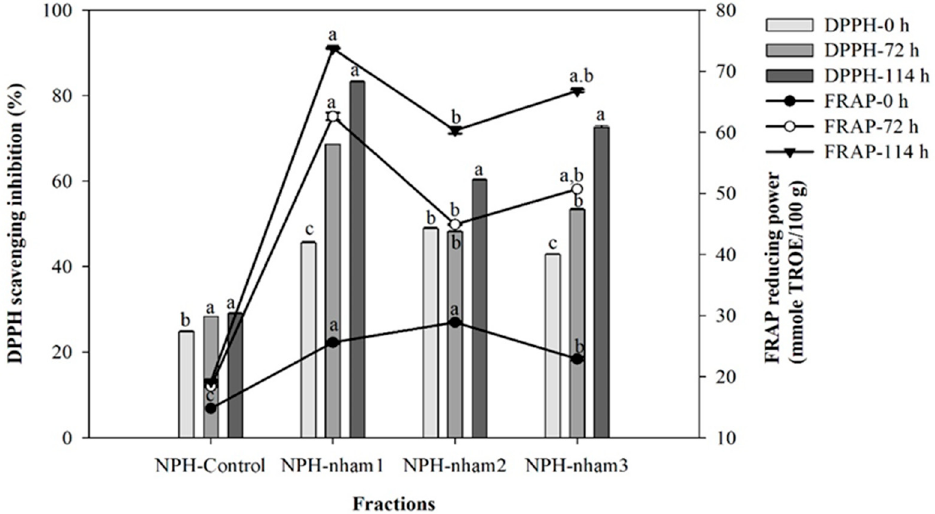
Figure 3. Antioxidant activity of different Nham protein hydrolysate fractions obtained during fermentation at different formulations, mixed with an encapsulated- Lactobacillus sp. starter. Different letters a,b,c in the same group indicate a significant difference by applying Duncan’s multiple range test ( p < 0.05).